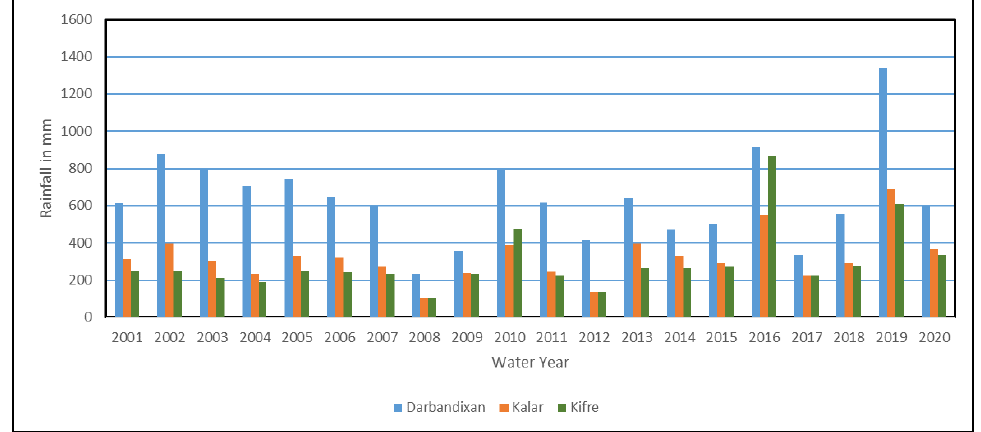
Figure 2. Average temperature historical map of Iraq (USGS).